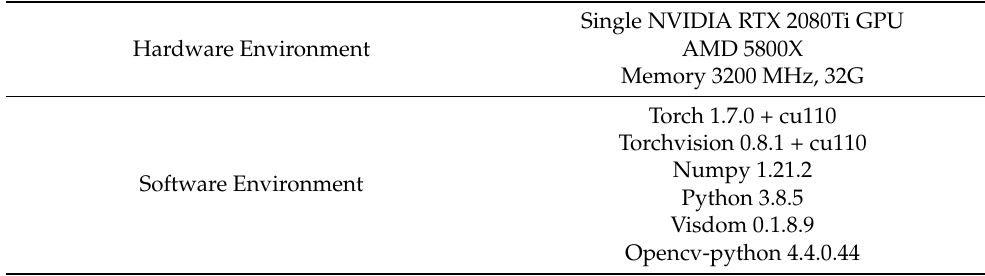
Table 1. Software and hardware environment required for our